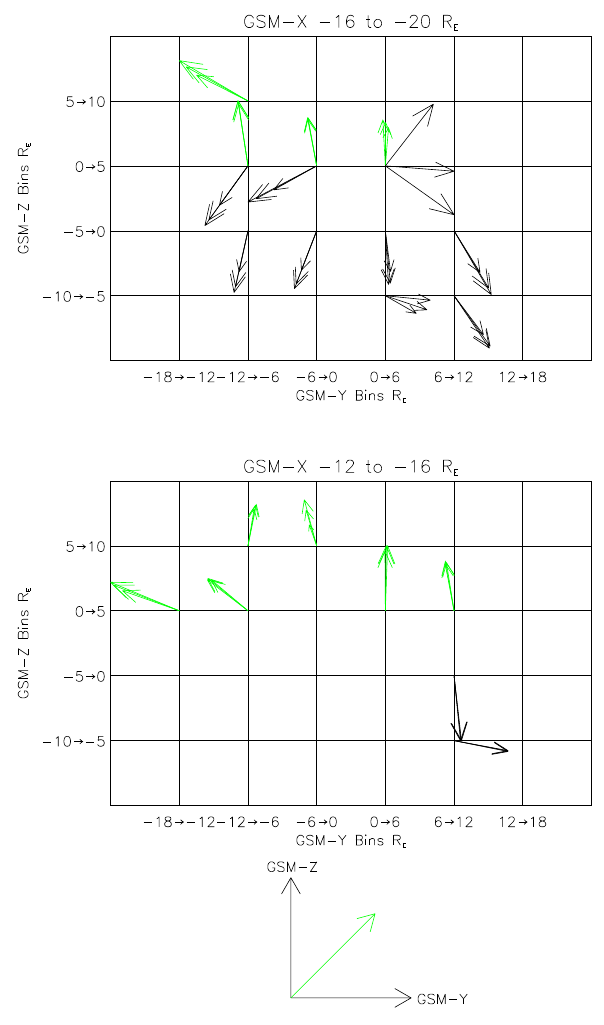
Fig. 13. The projection of the average unit normal of the boundary between the expanding plasma sheet and the lobe in the GSM–ZY direction is shown as a function of position in the GSM–ZY plane for the north lobe (green vectors) and south lobe (black vectors). Error bars, calculated from the extreme errors on the individual vec- tors, are plotted when more than one normal vector was used for the